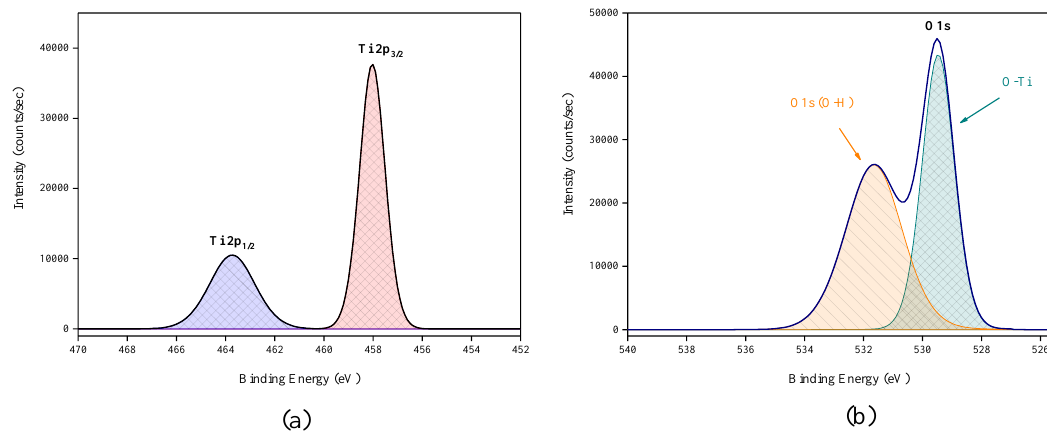
Figure 10. High resolution XPS spectra of ( a ) Ti2p peak and ( b ) de-convoluted O1s peak.